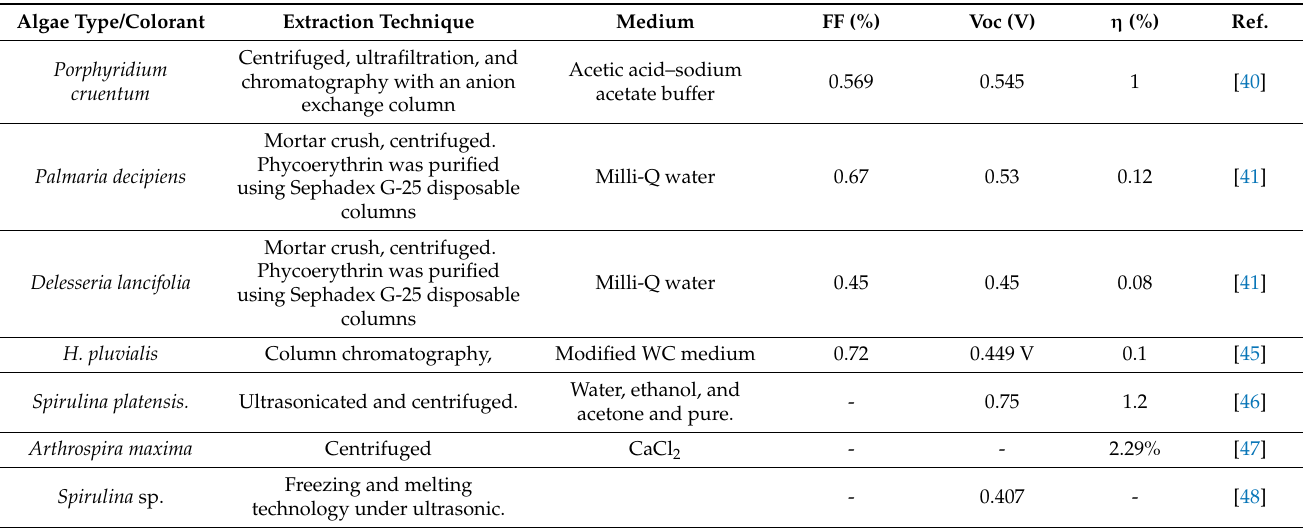
Table 1. Summary of microalgae species with great potential in the use of DSSC.